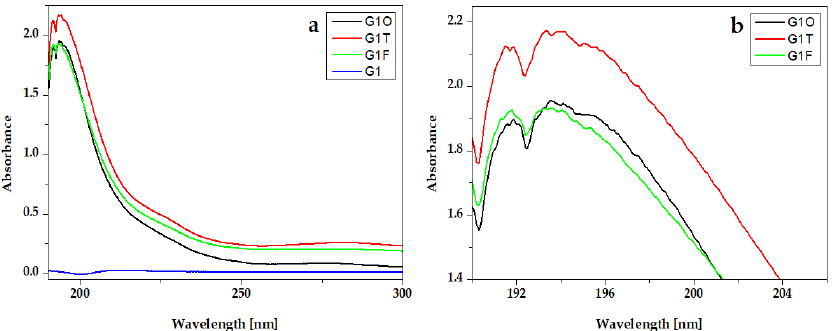
Figure 5. UV-VIS absorption spectra of experimental gels G1 with Oregano ® (G1O), Thieves ® (G2O), and Frankincense ® (G2F) essential oils: ( a ) full-length spectra and ( b ) peaks details.